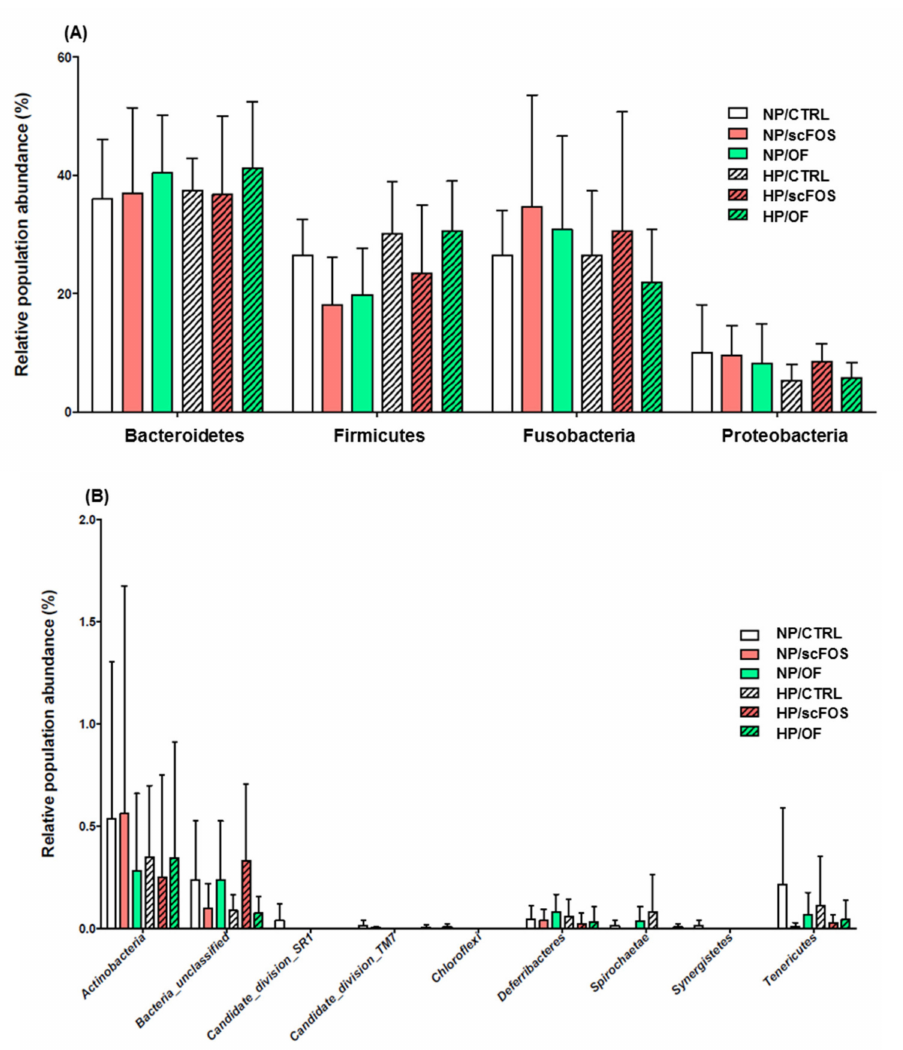
Figure 3. E ff ects of prebiotic supplementation and dietary protein level on major ( A ) and minor ( B ) phyla found in the fecal microbiota of obese dogs. CTRL: control; OF: oligofructose; scFOS: short-chain fructo-oligosaccharides; NP: normal protein; HP: high